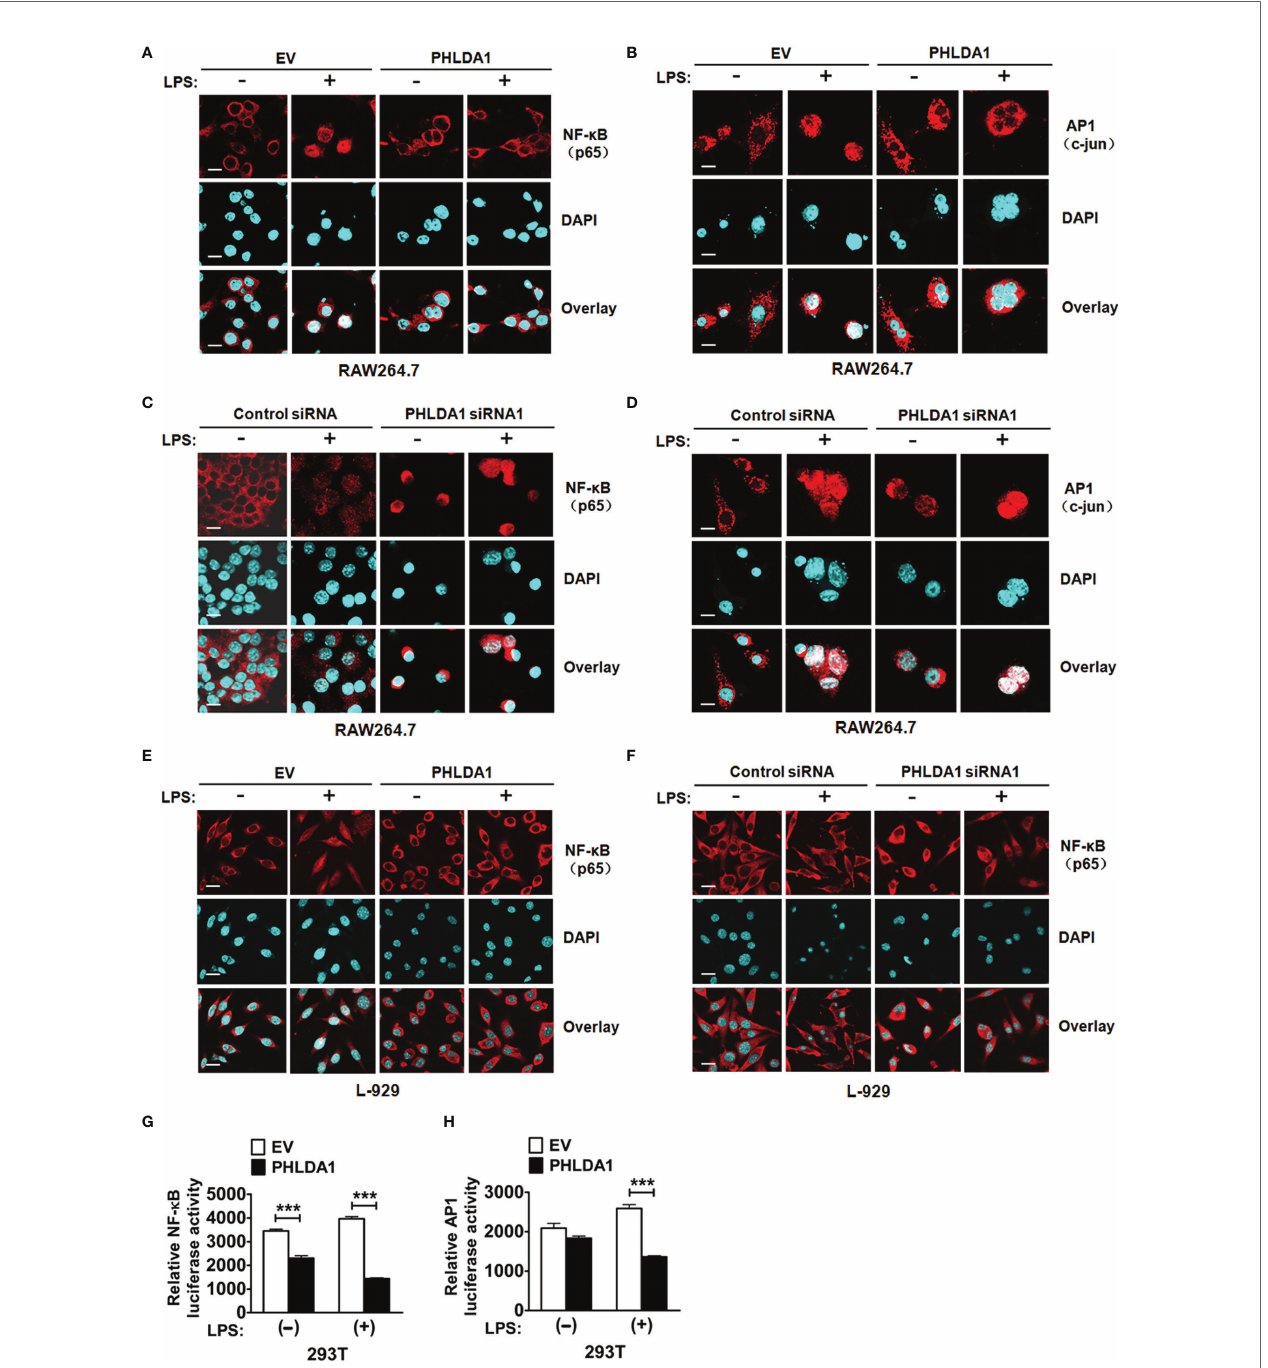
FIGURE 4 | PHLDA1 attenuates LPS-initiated nuclear translocations and responsive element activities of NF- k B and AP1. RAW264.7 cells (A, B) and L-929 cells (E) were transfected with EV or PHLDA1 plasmid, and then stimulated with or without LPS (0.1 m g/ml) for 1 h. Cells were immunostained with anti-NF- k B (p65) antibody or anti-AP1 (c-jun) antibody and Alexa-594-labeled secondary antibodies. The nuclei were stained with DAPI for 15 min. The merged images were captured with a confocal microscope (scale bar, 20 m m). RAW264.7 cells (C, D) and L-929 cells (F) were transfected with Control siRNA or PHLDA1 siRNA1, and then stimulated with or without LPS (0.1 m g/ml) for 1 h. Cells were immunostained with anti-NF- B (p65) antibody or anti-AP1 (c-jun) antibody and Alexa-594-labeled secondary antibodies. The nuclei were stained with DAPI for 15 min. The merged images were captured with a confocal microscope (scale bar, 20 m m). (G, H) EV or PHLDA1 plasmid was transfected into 293T cells together with pTK – Renilla luciferase and NF- k B luciferase reporter plasmids. After 24 h of culture, the cells were incubated with LPS (0.1 m g/ml) for 20 h. The Dual-Luciferase ® Reporter (DLR ™ ) Assay System was performed to measure NF- k B or AP1 luciferase activity. Data are presented as mean ± SD of three independent experiments (*** P <